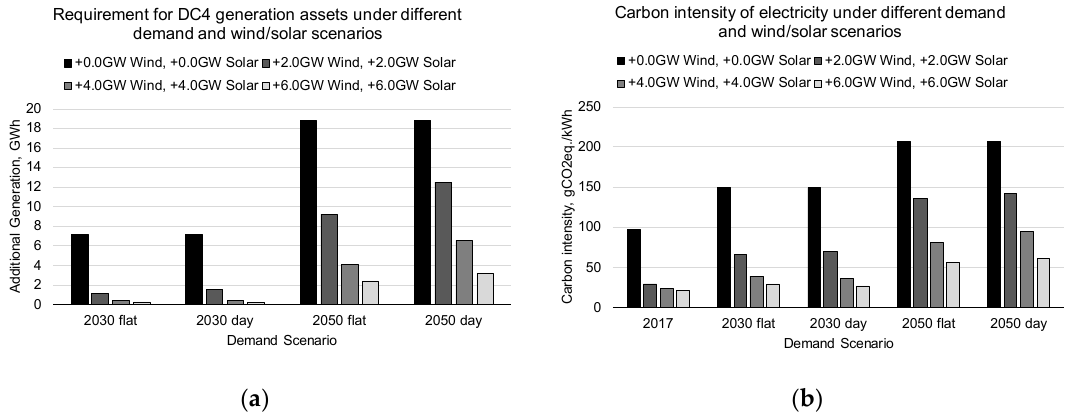
Figure 7. ( a ) Requirements for DC4 assets and ( b ) carbon intensity under different demand scenarios in New Zealand. Note that additional generation required to meet demand is assumed to be gas generation as the lowest carbon fossil fuel based DC4 asset.